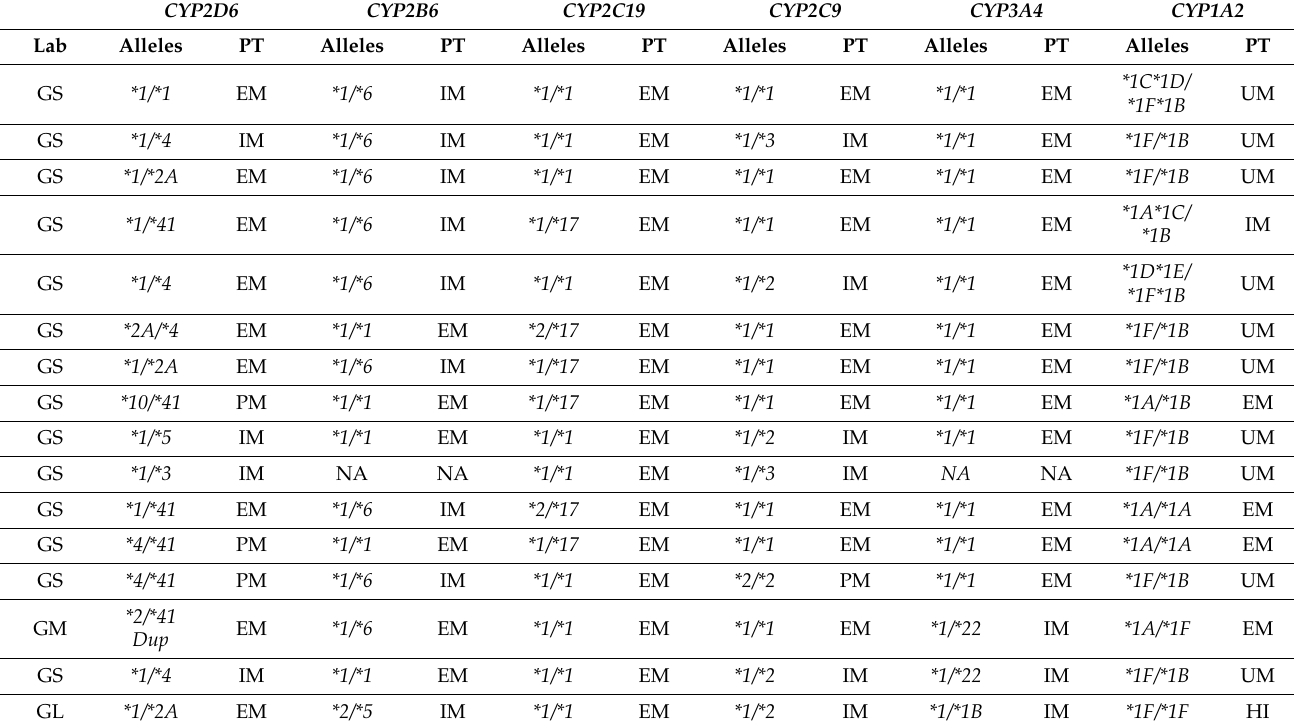
Table A3. Pharmacogenetic data for cytochrome P450 enzymes in PWS cohort with UPD: Testing laboratory, CYP genotype, and CYP